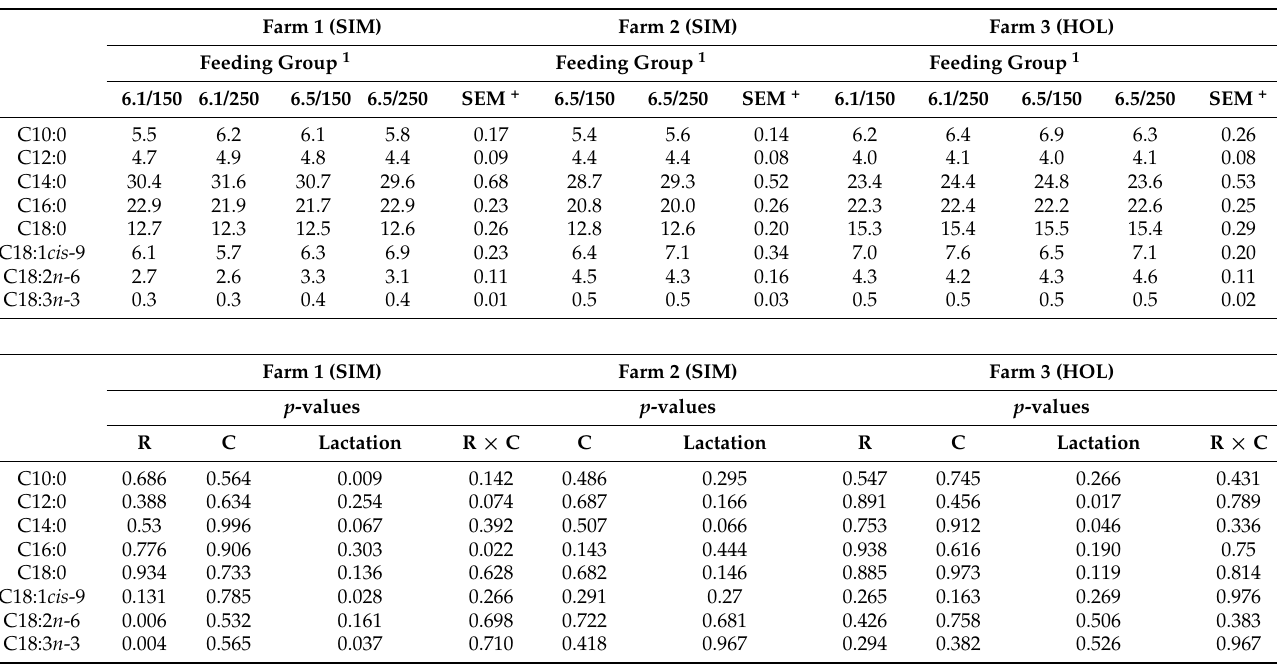
Table 3. Feeding group-specific effects within each farm on the fatty acid composition of hair taken in lactation week 8. In the upper part, LS-means of the relative amount of every fatty acid (% of total fatty acids) per feeding group is shown, in the lower part, p -values are given for the effects of the energy concentration of the roughage (R), the concentrate supply (C), the lactation number (Lactation), and the interaction between the energy concentration of the roughage and the amount of concentrate supply (R × C in farm 1 and